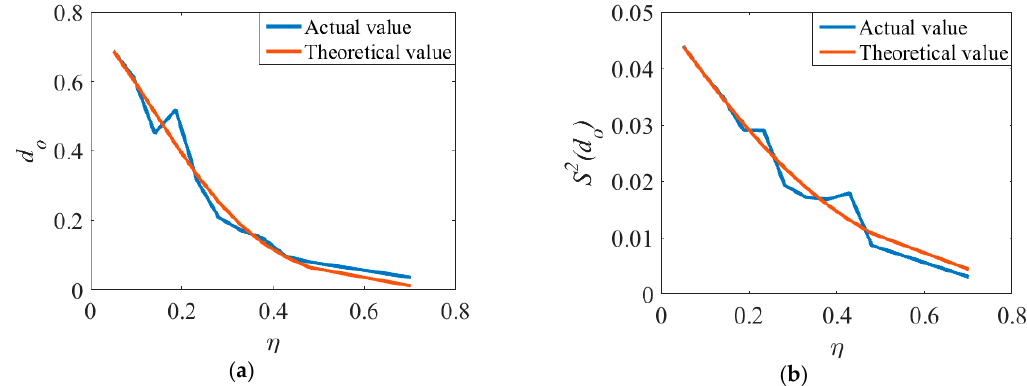
Figure 9. Several distribution curves of actual and theoretical crushed products under different single-layer compression ratios: ( a ) η a = 0.095; ( b ) η a = 0.23; ( c ) η a = 0.38; ( d ) η a = 0.48.